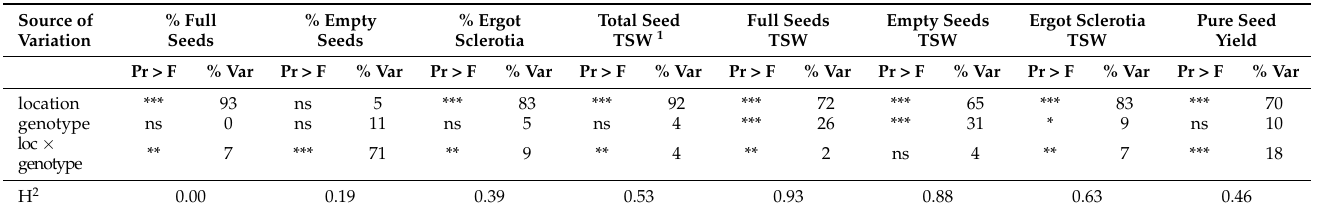
Table 3. Significance levels, percentage of the variance explained by the different sources of variation, and broad-sense heritability for the different total seed fraction